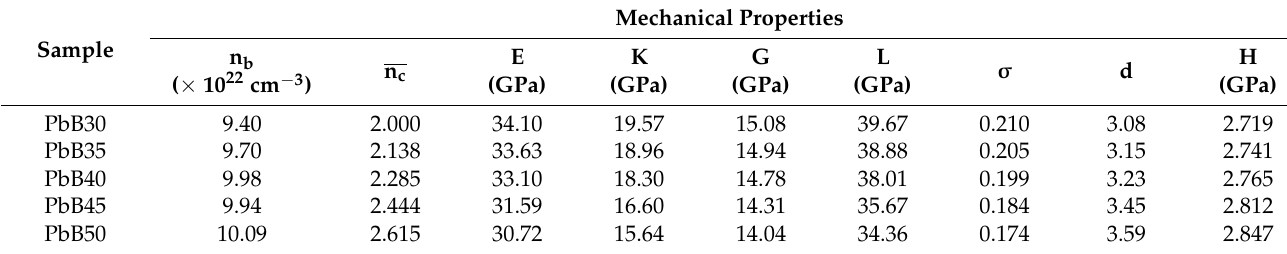
Table 2. Mechanical properties of the examined